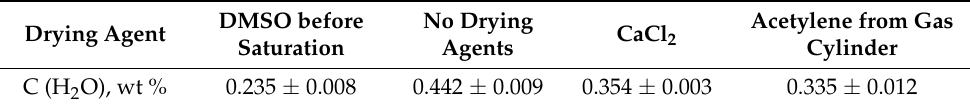
Table 3. Content of water in DMSO before and after saturation with acetylene. Acetylene from Gas DMSO before No Drying CaCl 2 Drying Agent Saturation Agents